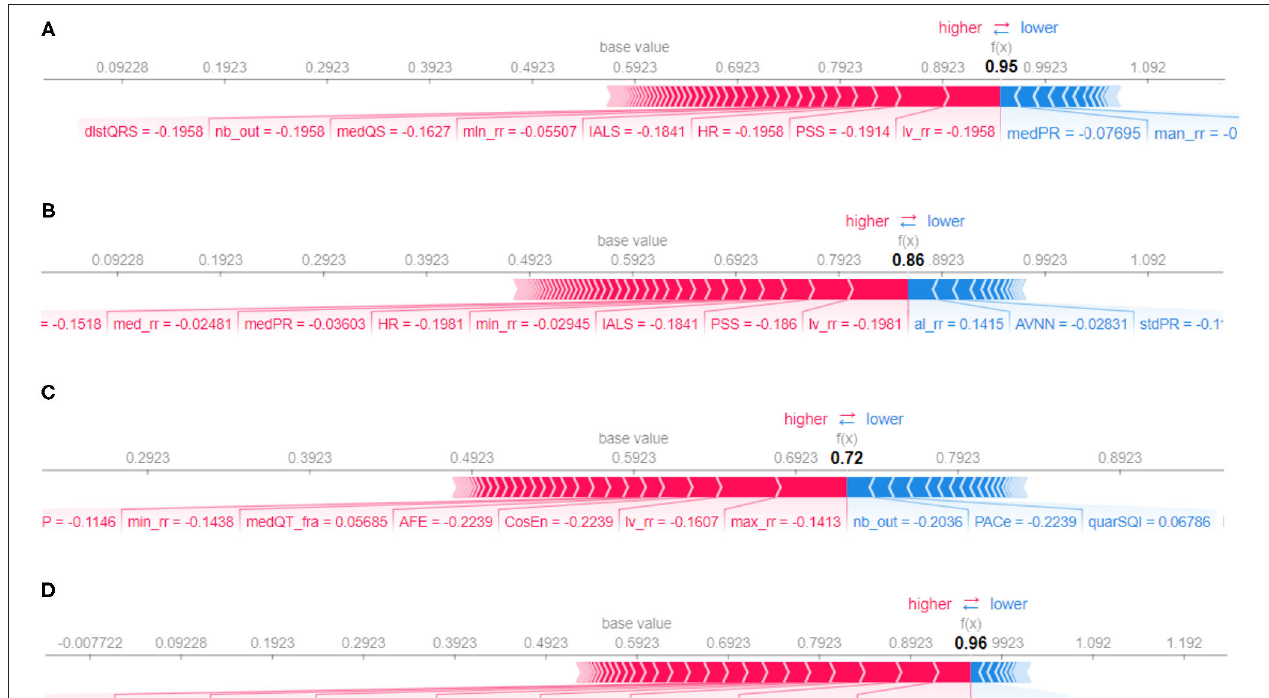
FIGURE 10 | Force plot for different samples, selected randomly from test set, corresponding to class atrial fibrillation (A) , class normal sinus rhythm (B) , class other rhythms (C) , and class noisy recordings (D) , respectively.